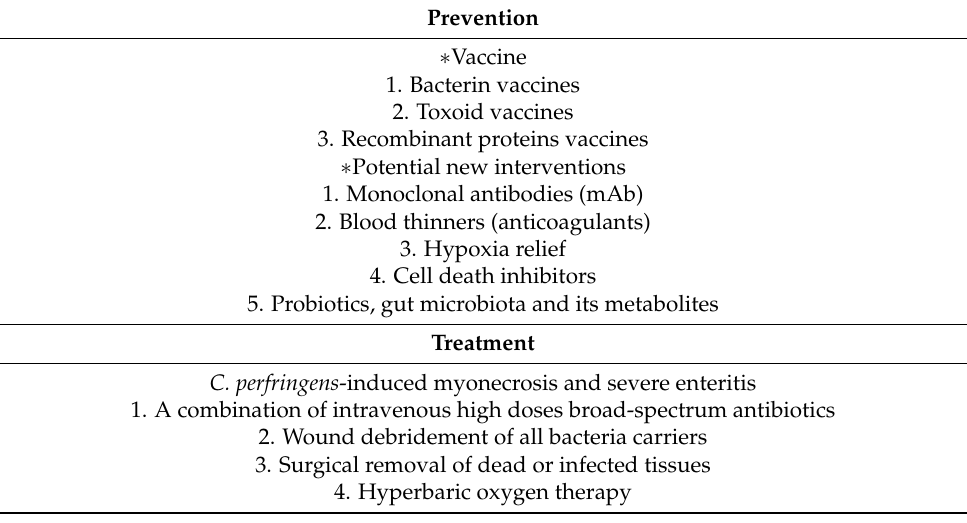
Table 2. Prevention and treatment of C. perfringens -induced necrotic